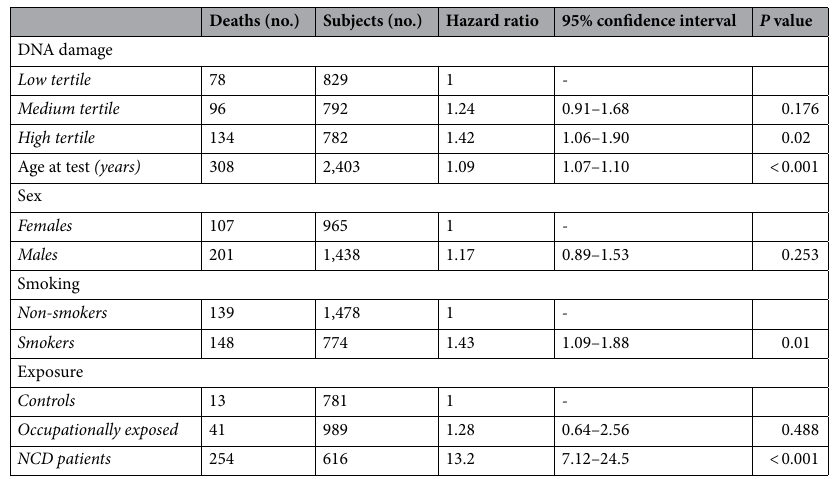
Table 3. Overall mortality risk by tertile of DNA damage measured with the comet assay (composite endpoint), age, sex, smoking habit, and occupational exposure/disease. The hCOMET cohort. For some predictors the sum of the frequencies of each category does not amount to the overall due to missing values.